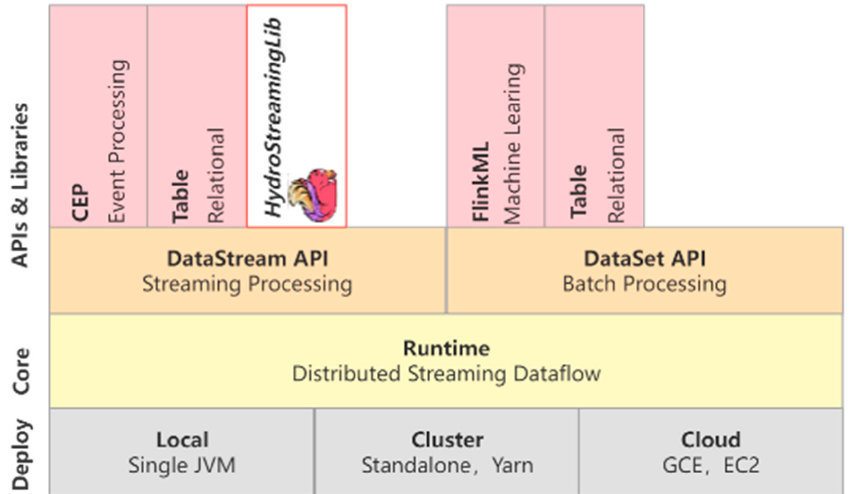
Figure 1. HydroStreamingLib in the Flink stack.